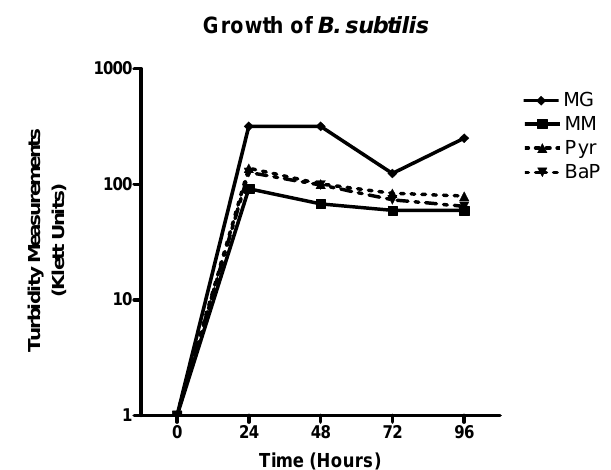
Figure 1: Growth physiology of B. subtilis in MM, MG, and MM+PAH.